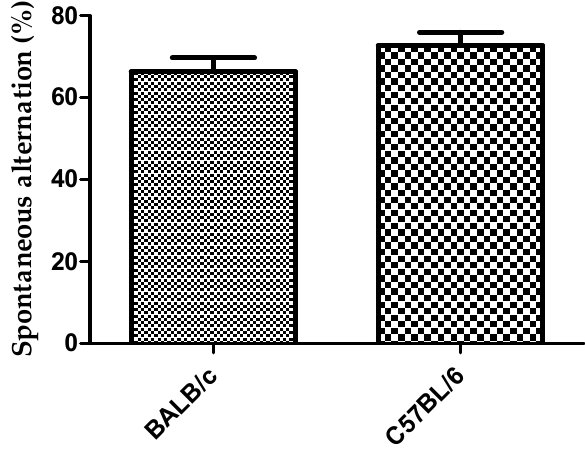
Figure 5. Response to Y-maze task (three arms free) for strains BALB/c and C57BL/6J mice in relation to spontaneous alternation. Data shows mean ± standard deviations for groups.